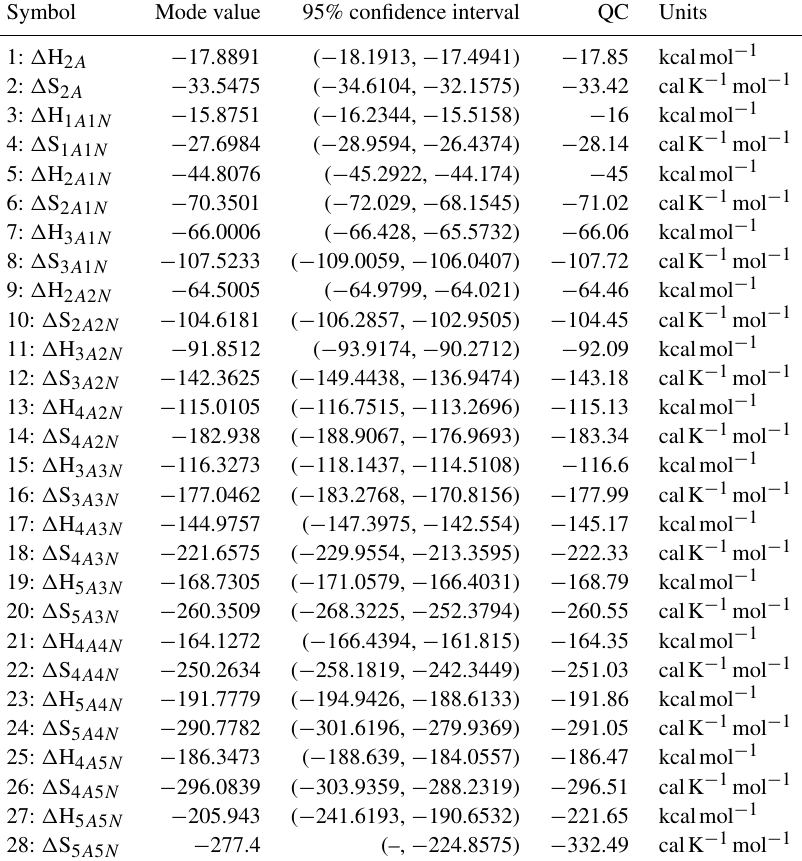
Table D1. Thermodynamic parameters identified from steady-state data measured at two temperatures (278 and 292K). The last column presents the quantum-chemistry-based values from Olenius et al. (2013b) used to generate the synthetic data. Here, the symbols (cid:49) H and (cid:49) S stand for cluster formation enthalpies and entropies, respectively. The notation xAyN corresponds to a cluster with x sulfuric acid and y ammonia